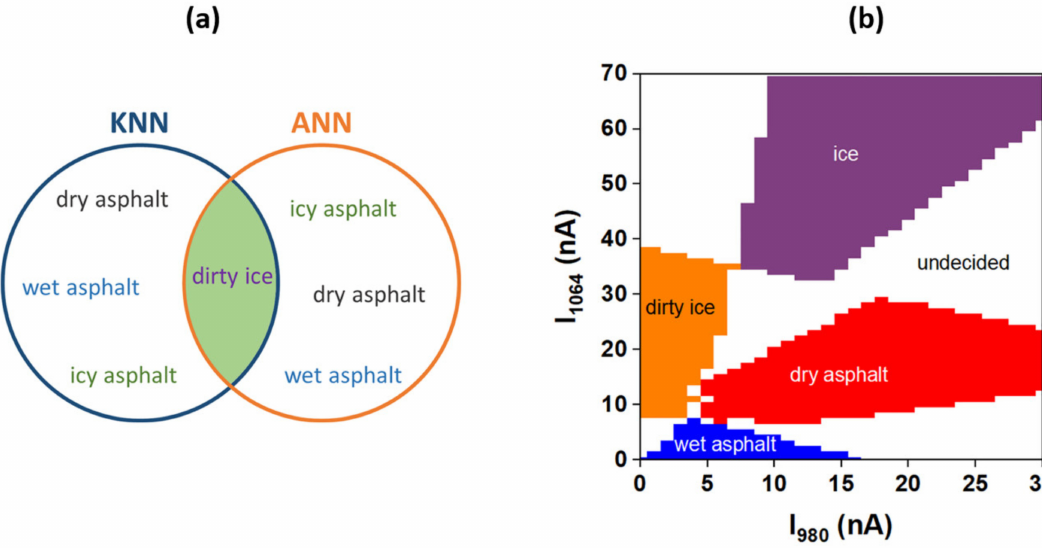
Figure 9. KNN and ANN algorithms’ classification intersection: ( a ) a schematic example of the intersection of the classification results of the KNN and ANN algorithms for the dirty ice state and ( b ) results of KNN and ANN intersection applied on the array